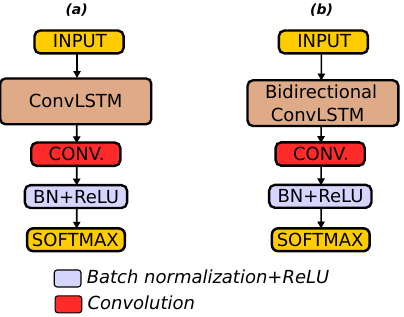
Figure 3. LSTM structure diagram (Bermudez et al., Figure 4. RNN architectures adapted to many-to-many 2017). tasks: (a) UConvLSTM, (b) BConvLSTM. layer. The BConvLSTM network comprises two ConvLSTMs: one processes the input data in the forward direction, while the other operates in reversed, backward direction. The outputs of both ConvLSTM are concatenated to form a single output tensor. From this point on, the architecture does not differ from the previous